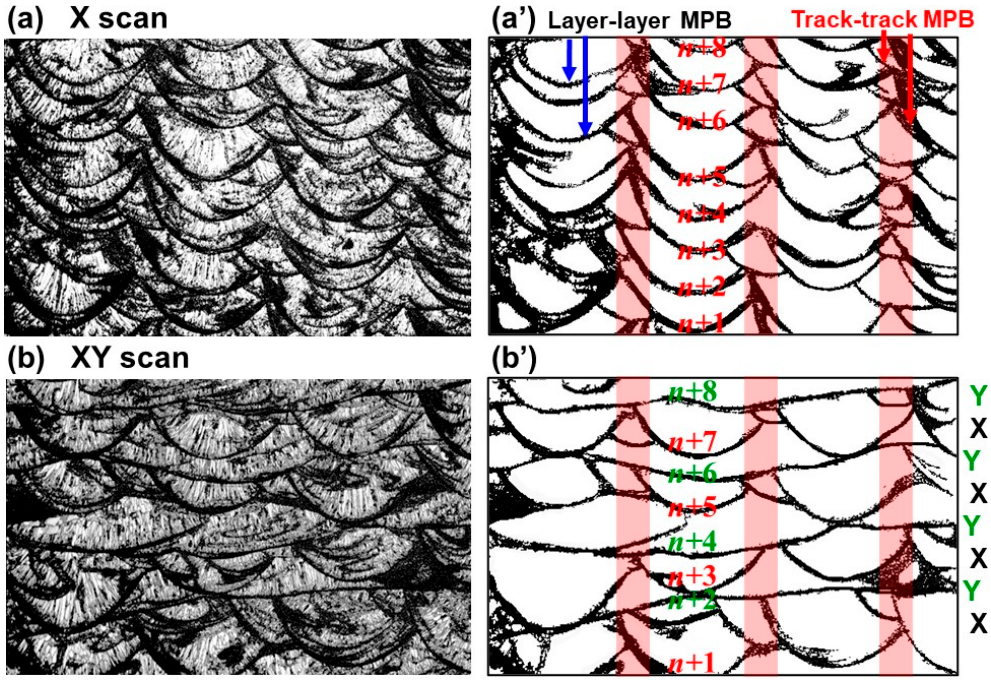
Figure 8. ( a , b ) BC images and ( a’ , b’ ) configurations of the extracted MPBs of X- and XY-scans.